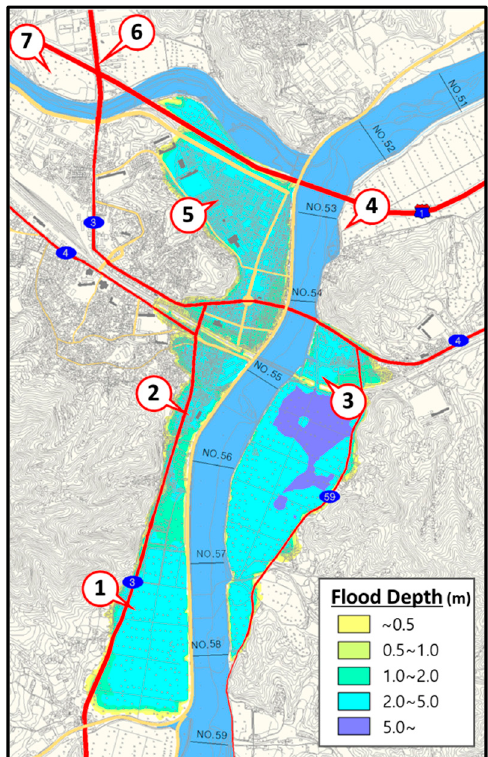
Figure 16. Flood hazard map of Ministry of Land, Infrastructure and Transports (MOLIT) [33].